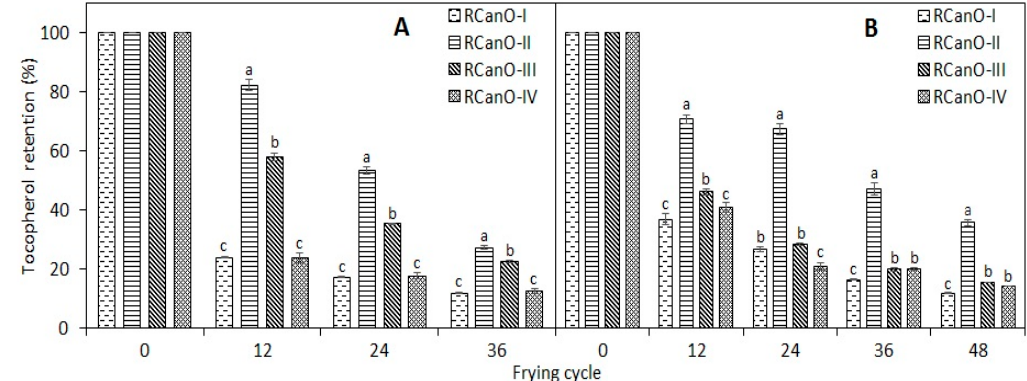
Figure 5. Tocopherols retention in canola oils during 36 ( A ): 2016/2017 production season and 48 ( B ): 2017/2018 production season, frying cycles. Different letters show means that are statistically significant from each other ( p < 0.05).